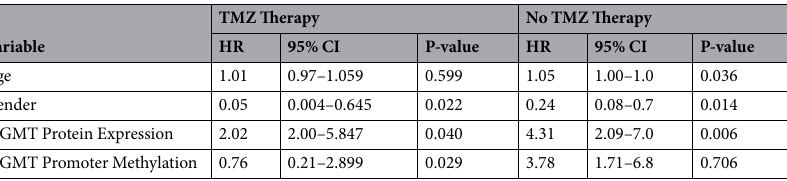
Table 4. Multivariate analysis for determination of Survival in Glioma patient cohort treated with TMZ therapy status. HR: Hazard ratio; TMZ: